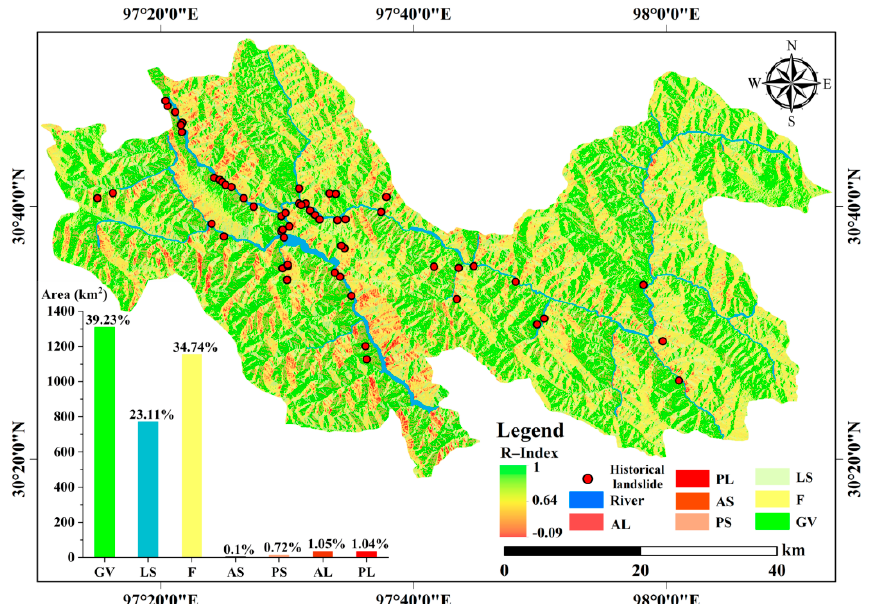
Figure 4. Visibility analysis by R-index. The abbreviations include: AL = active layover; PL = passive layover; AS = active shade; PS = passive shade; F = foreshortening; LS = low sensitivity; and GV = good visibility.